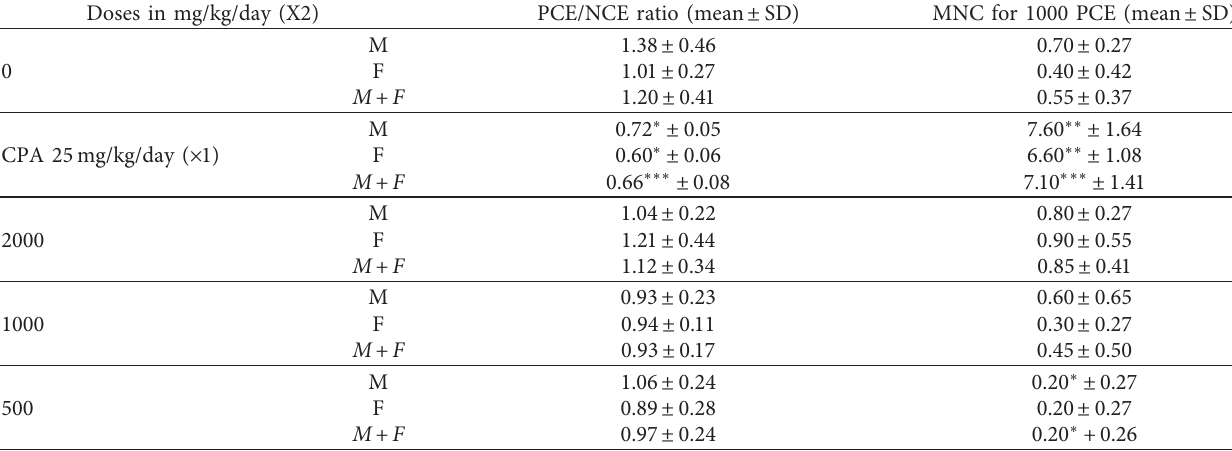
∗ Statistically significant at the threshold of p < 0 . 05, ∗∗ statistically significant at the threshold of p < 0 . 01, ∗∗∗ statistically significant at the threshold of p < 0 . 001 (PCE/NCE ratio: Student’s t -test; micronucleates frequency: Mann-Whitney U test). PCE: polychromatic erythrocytes; NCE: normochromatic erythrocytes; MNC: micronucleates; M: male rats; F: female